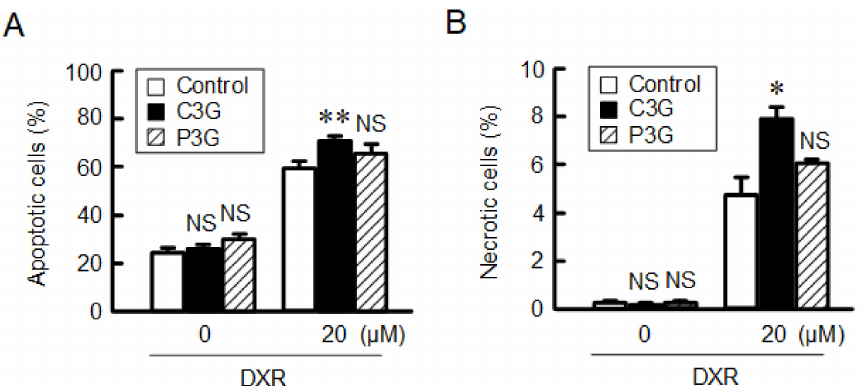
Figure 11. Increase in the rates of DXR-induced apoptotic and necrotic cell death by C3G. After being treated in the absence (control) and presence of 50 µ M anthocyanins for 24 h, the spheroid cells were incubated with 0 or 20 µ M DXR for 24 h. The rates of apoptotic ( A ) and necrotic cell death ( B ) were examined using a BZ-X800 fluorescence microscope. n = 4. ** p <0.01, * p <0.05, and NS p >0.05 compared with